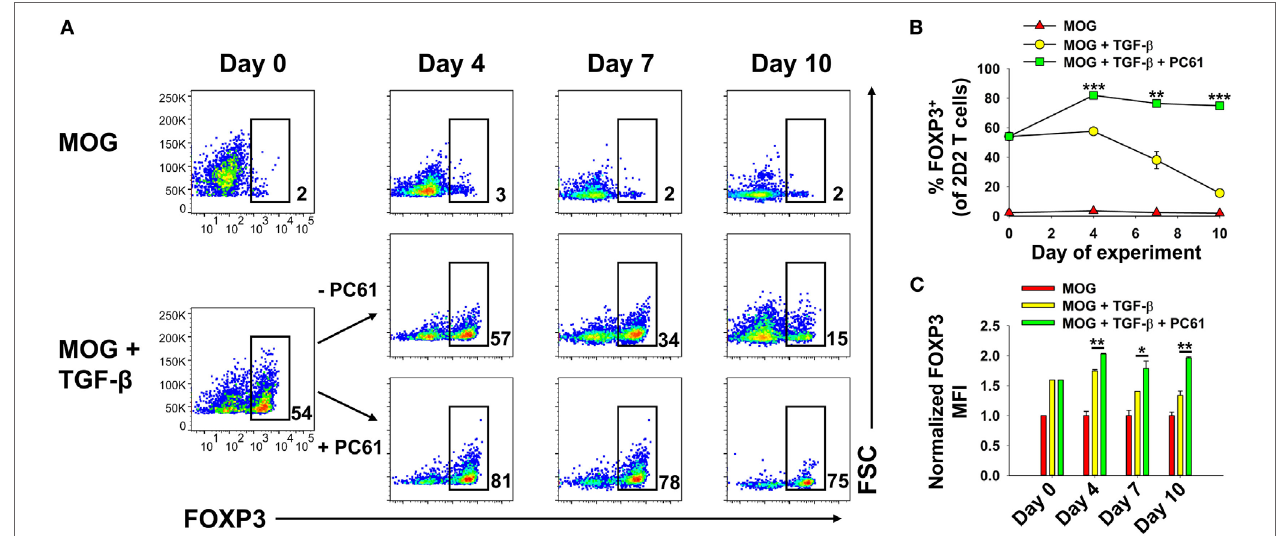
FigUre 4 | PC61 enabled the preferential outgrowth of TGF- β -induced iTregs from 2D2-FIG Rag1 − / − mice. 2D2-FIG Rag1 − / − mice splenocytes were activated for 4 days at a density of 2 × 10 6 cells/ml in cRPMI with MOG35-55 in the presence or absence of 1 nM TGF- β to generate regulatory T cells (Tregs) and conventional T cells, respectively, and were passaged at a density of 5 × 10 5 cells/ml in cRPMI with rat IL-2 on day 0 of the rest phase. T cells were then passaged with or without PC61 (10 µg/ml) (in the absence of TGF- β and MOG) as designated every 2–4 days. V β 11 + T cells were assessed for FOXP3 expression on days 0, 4, 7, and 10 after activation. Shown are representative dot plots of the percentage of FOXP3 + Tregs in the V β 11 + T cell population (a) and the corresponding averages of triplicate samples (B) . The bar graph shows the geometric MFI of FOXP3 expression in the FOXP3 + gate (c) . The geometric mean fluorescence intensity was normalized so that the FOXP3 MFI of Tregs activated in the absence of TGF- β was equal to 1. * p < 0.05, ** p < 0.01, *** p < 0.001. These experiments are representative of three independent